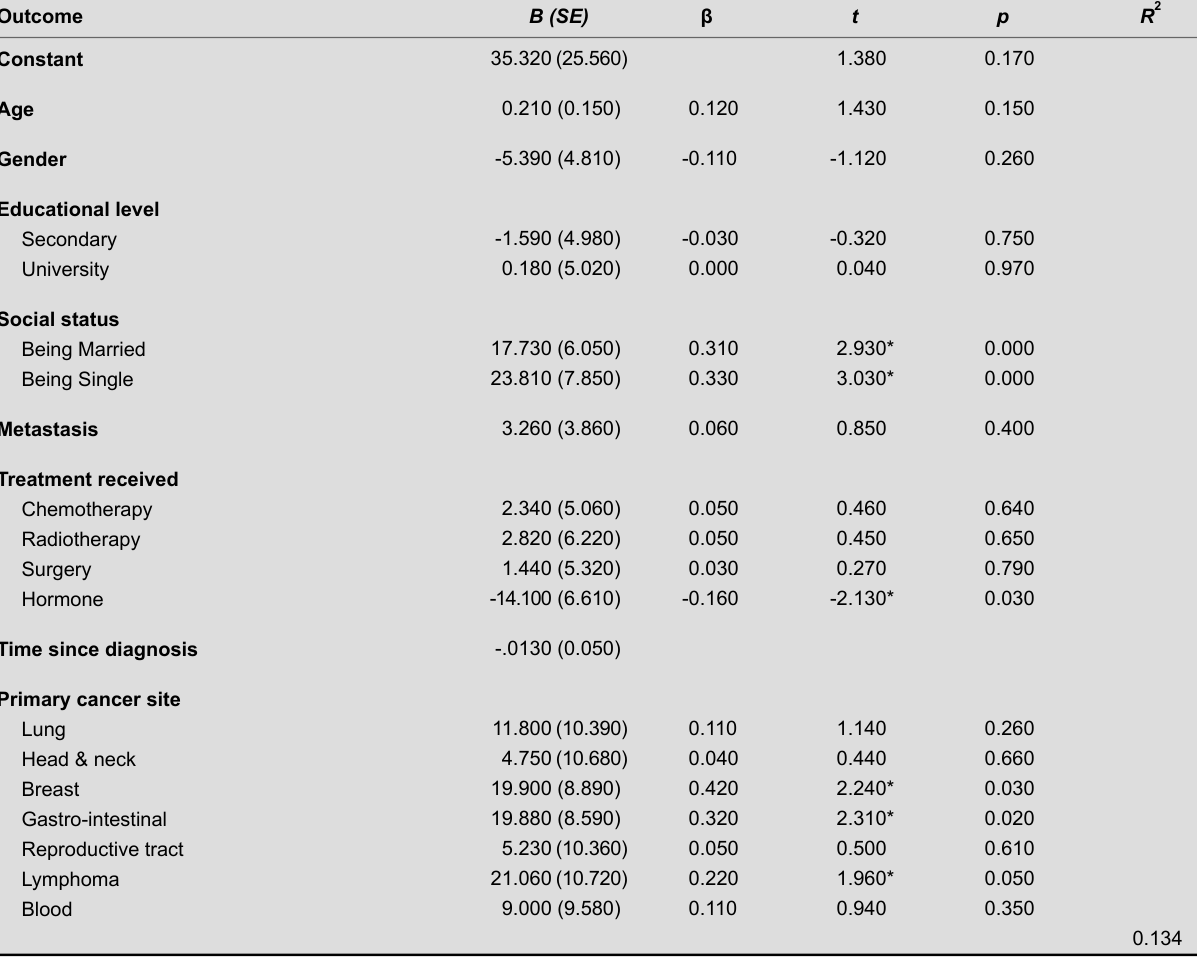
Patients’ Characteristics as Predictors of Quality of